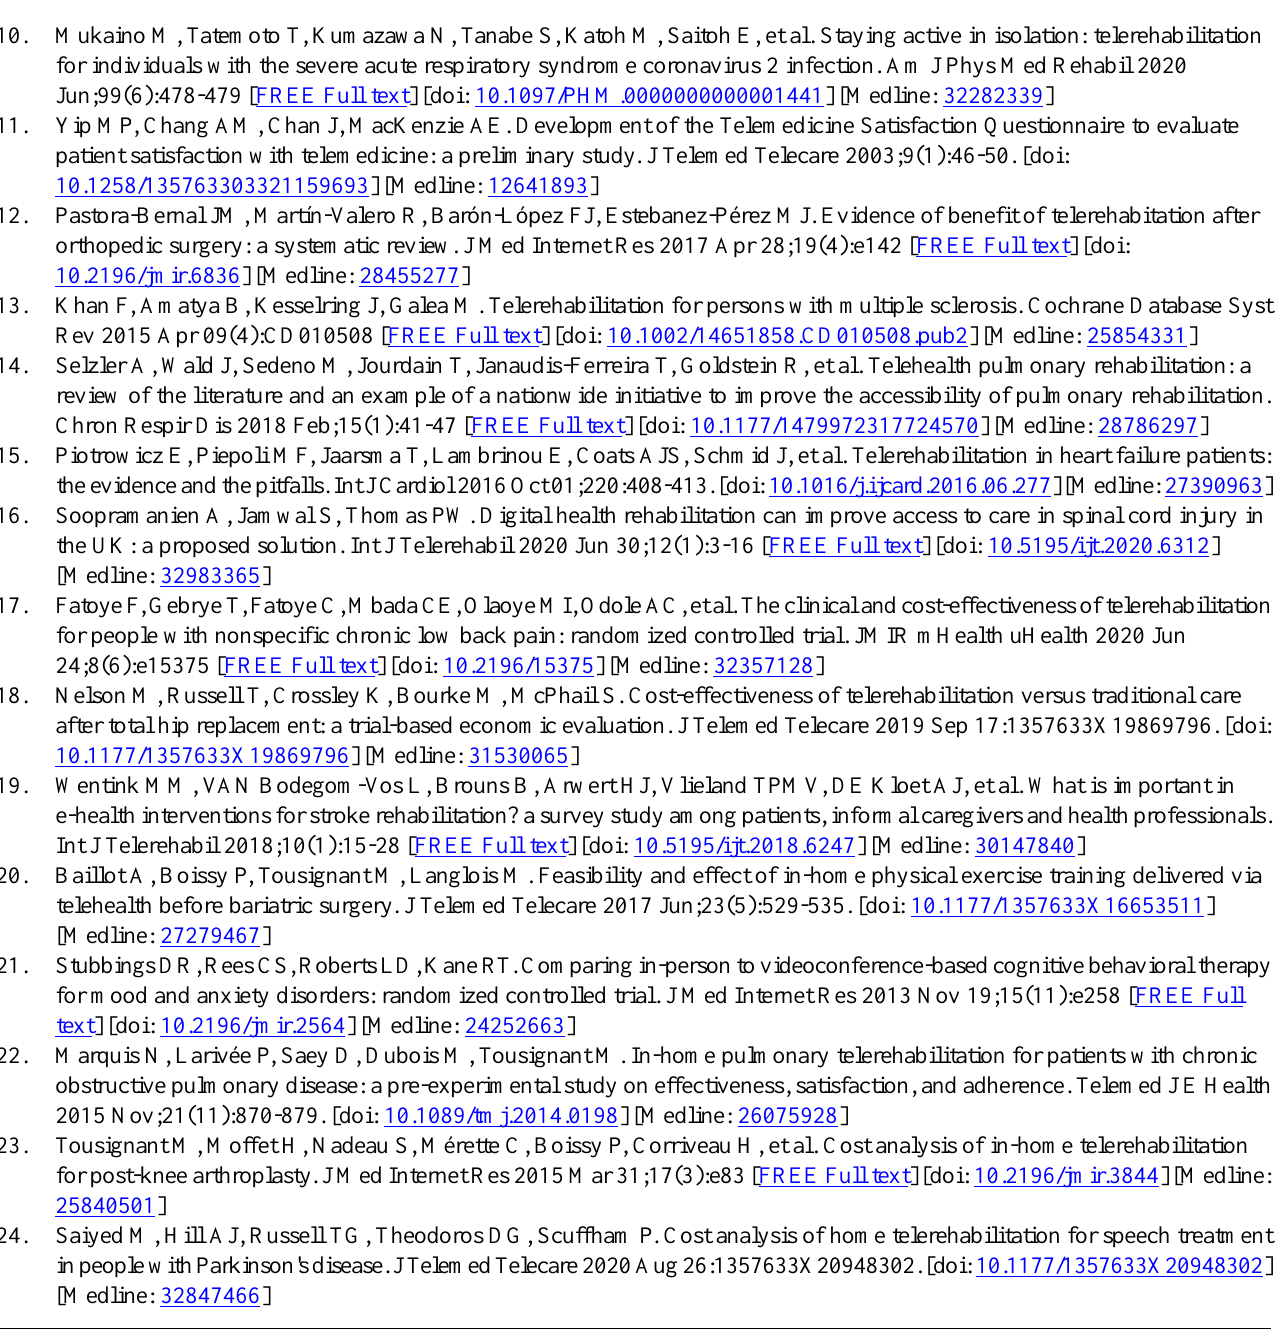
TSQ: Telemedicine Satisfaction